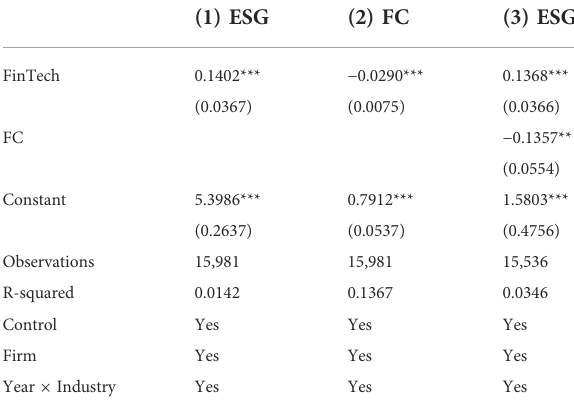
TABLE 7 Mechanism tests based on fi nancing